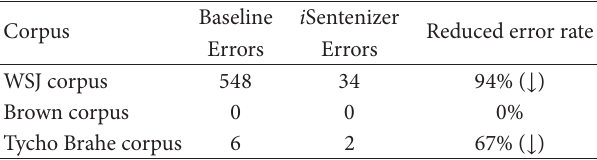
Table 9: Abbreviations classification error rate.